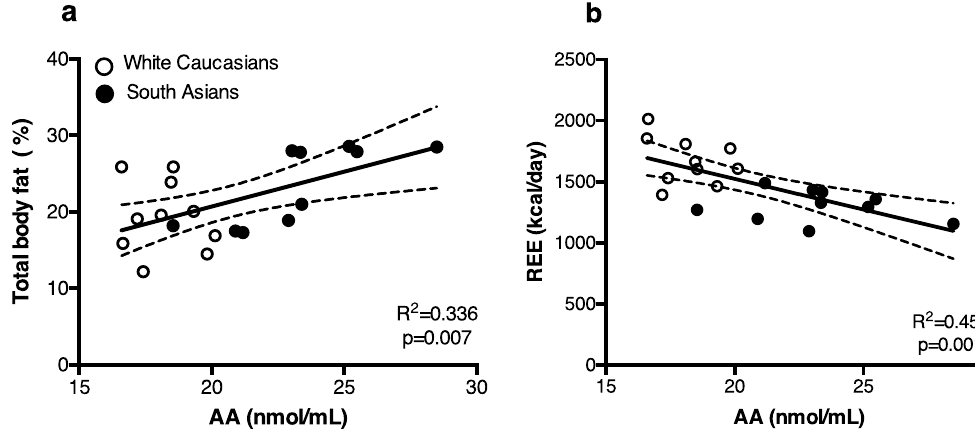
Figure 4. Thermoneutral plasma AA levels positively correlate with body fat percentage and negatively correlate with resting energy expenditure. Scatterplot of the correlations between plasma AA levels measured at thermoneutrality and total body fat percentage ( a ) or thermoneutral resting energy expenditure (REE) ( b ) (n = 20). Correlations are shown for the total group combined, black circles are South Asian individuals and white circles are white Caucasian individuals, with 95% confidence limits. Correlations were analysed using linear regression